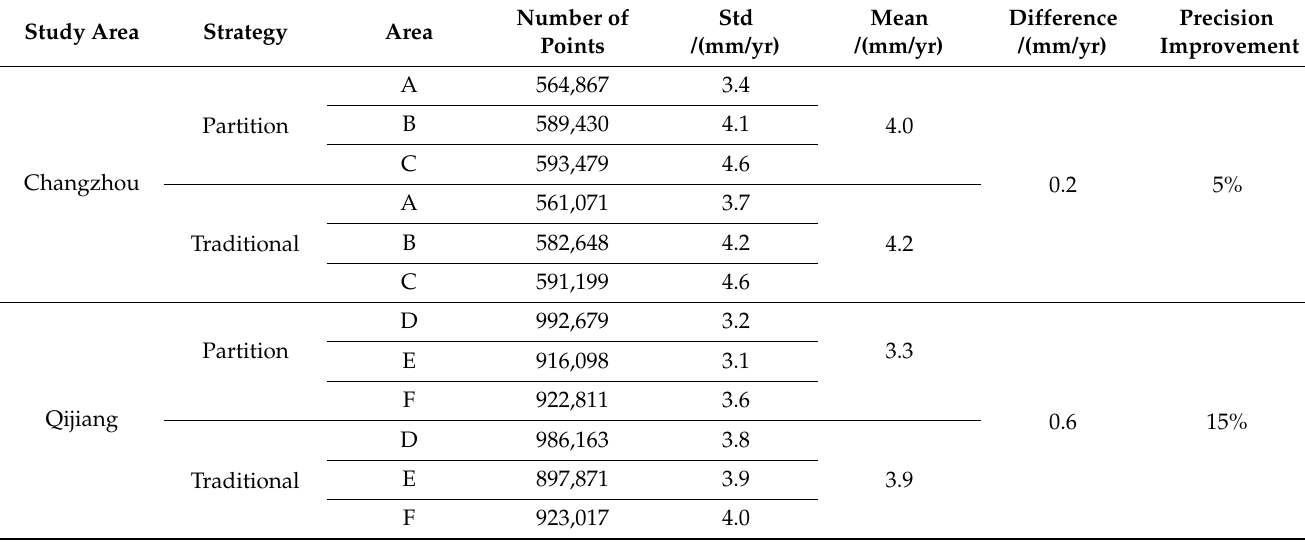
Table 2. Precision of the deformation velocity in Changzhou and Qijiang found by the two